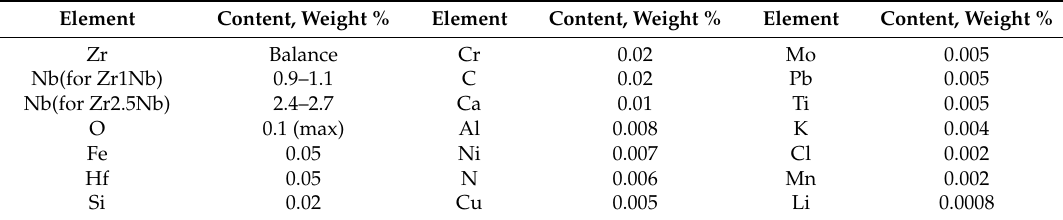
Table 1. Elemental composition of Zr-Nb